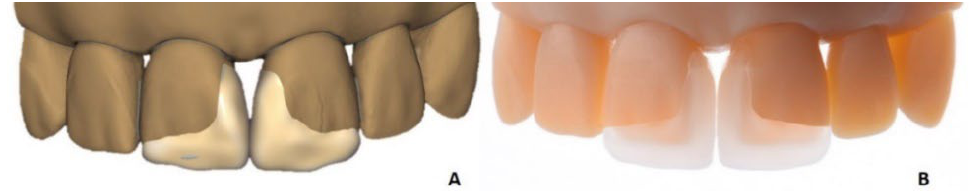
Figure 5. ( A ) virtual design of non-prep veneers for diastema closure; ( B ) LCM-manufactured non-prep veneers with the minimal thickness of 0.1 mm.